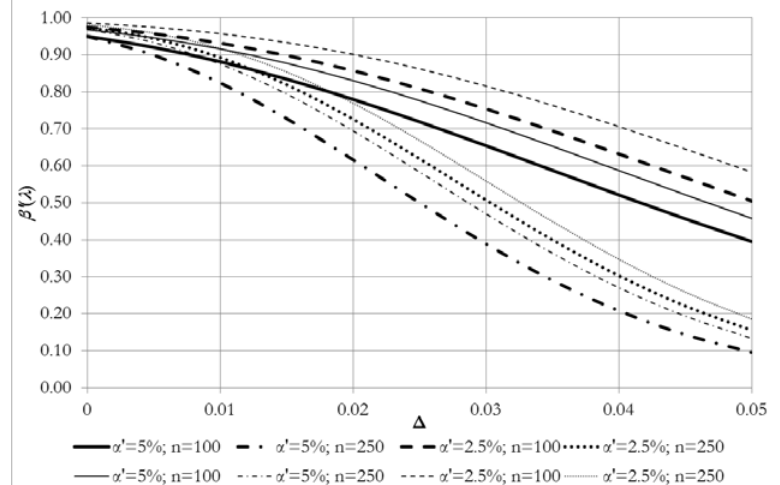
Figure 1 – Probability to accept the null hypothesis of the first test for the randomized (thick lines) and non-randomized (fine lines)